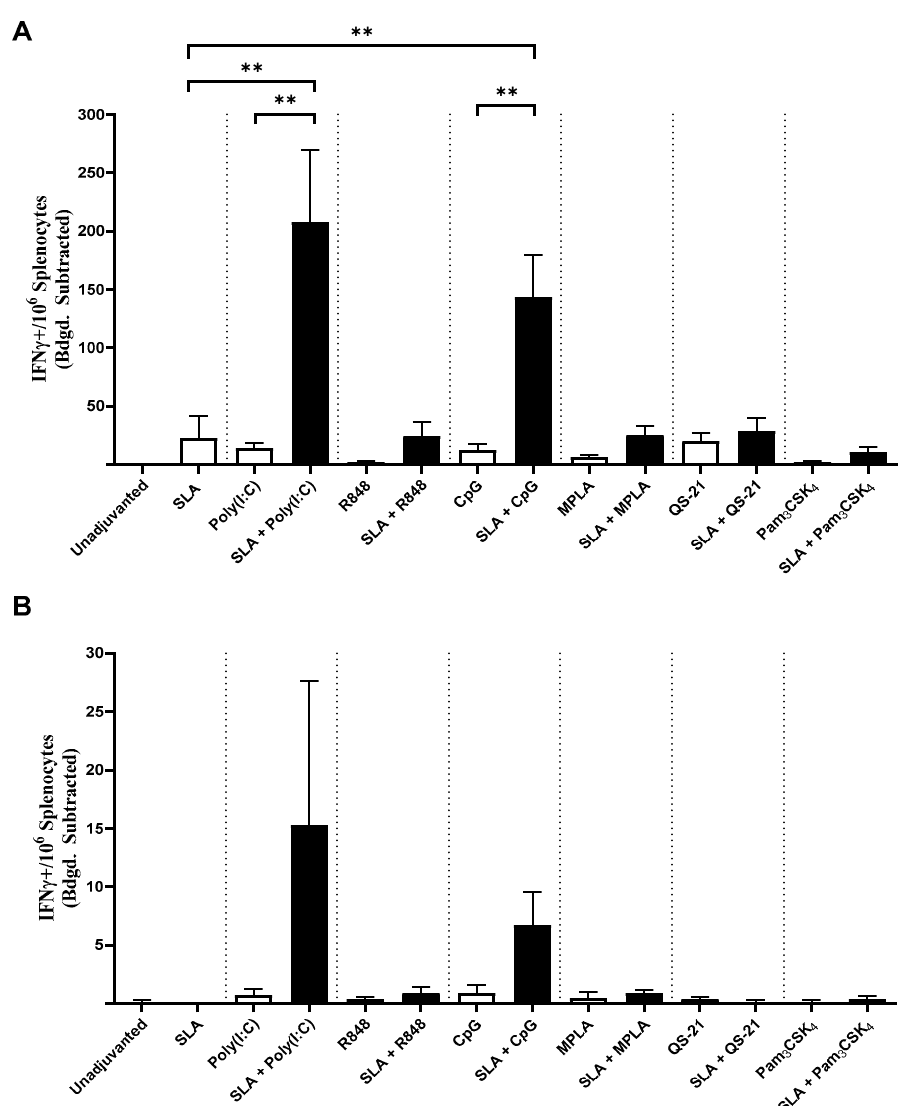
Figure 4. OVA-specific T cells as determined by ELISpot. Splenocytes of mice immunized with OVA antigen alone or formulated with SLA archaeosomes, other adjuvants (Poly(I:C), R848, CpG, MPLA, QS-21, Pam 3 CSK 4 ) or SLA in combination with other adjuvants were collected on day 28 (7 days post-2nd immunization) and analyzed by IFN- γ ELISpot when stimulated by CD8 peptide ( A ) or CD4 peptide ( B ). Grouped data are presented as mean + SEM ( n = 10/group). ** represents p < 0.01.